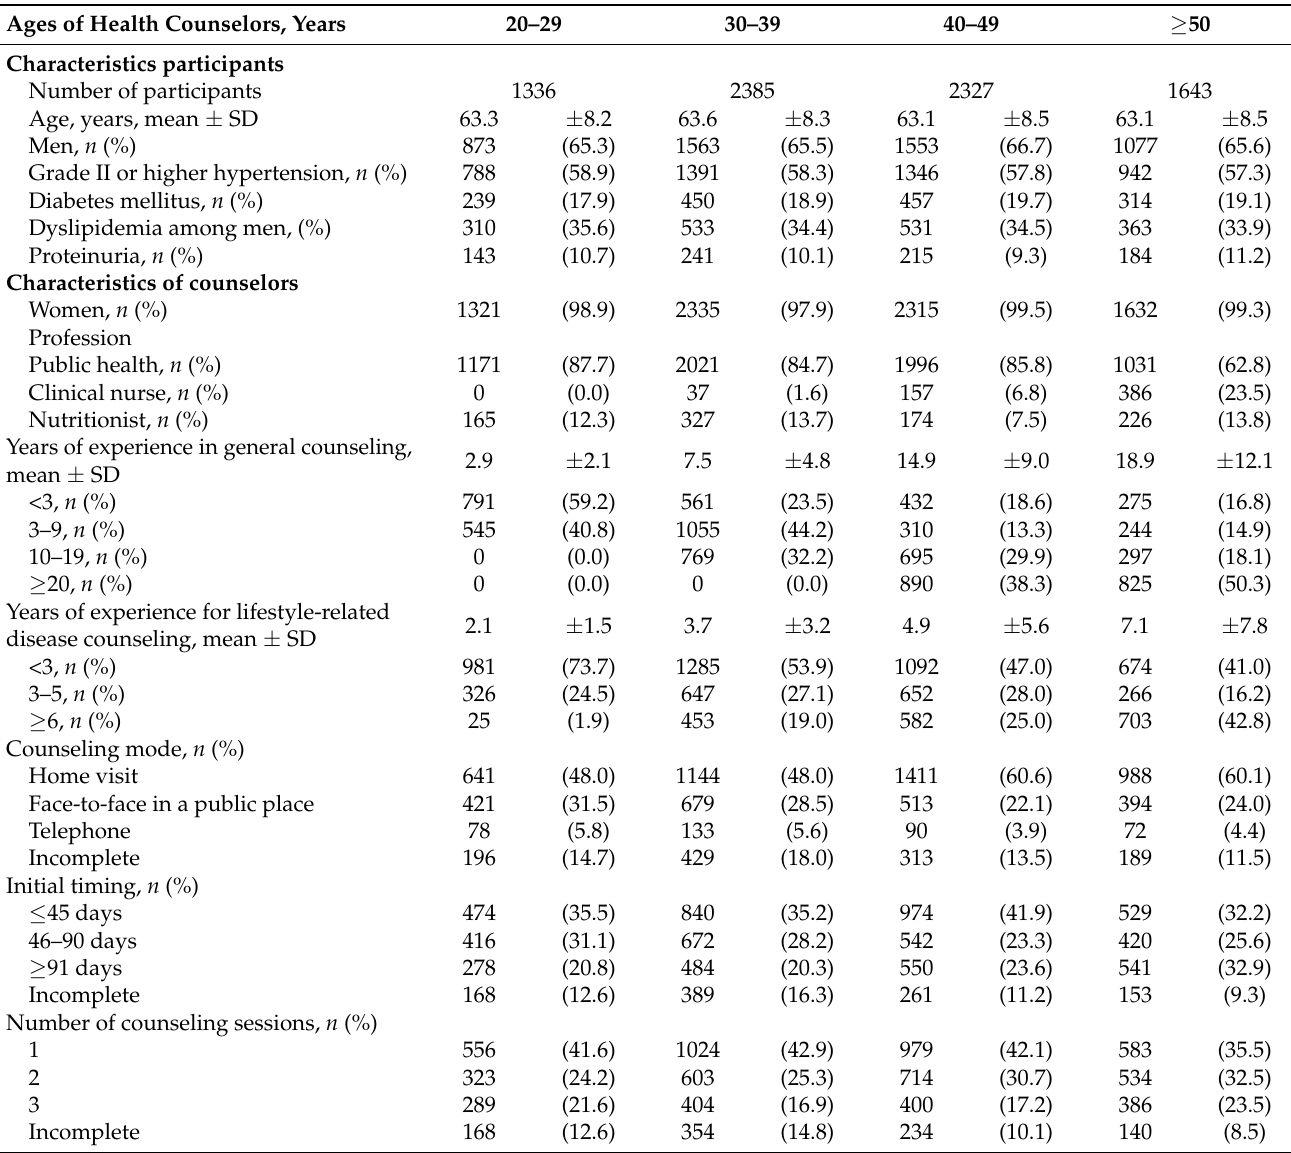
Table 2. Characteristics the participants and counselors according to the age of the